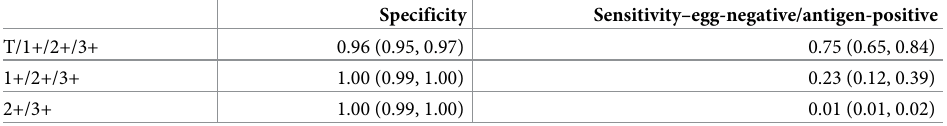
Table 3. Model-based estimates of the specificity and sensitivity for egg-negative infections of